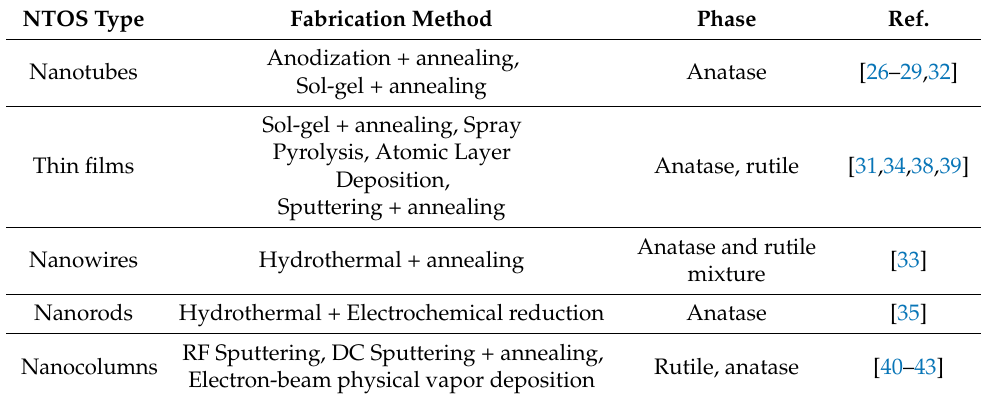
Table 1. Relationship between NTOS type and the fabrication method.